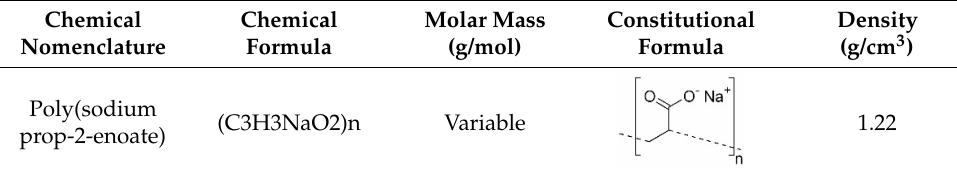
Figure 2. Scanning electron microscope images of SAP A, SAP B, SAP C, and SAP D for 5.0 kV 8.0 mm × 30 (clockwise from top left, respectively) [41]. Table 3. Chemical and physical properties of SAPs used.